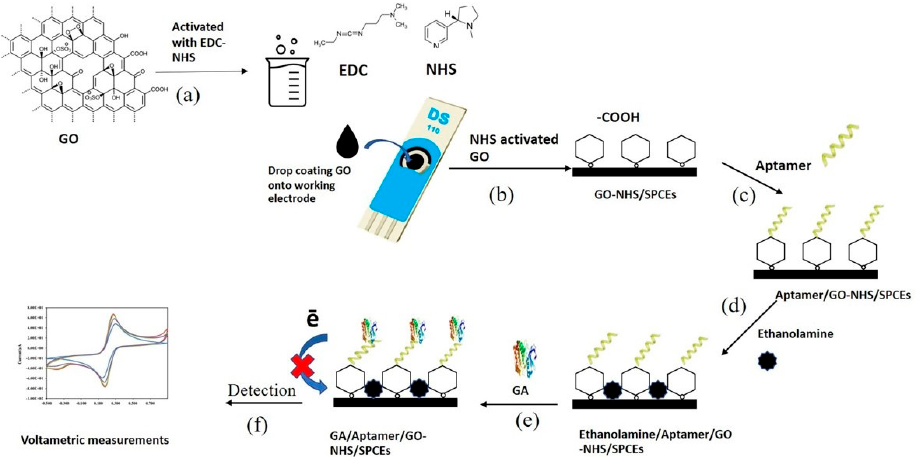
Figure 1. Schematic illustration of the proposed GO-based electrochemical aptasensor for GA protein detection. ( a ) Func- tionalization of GO; ( b ) drop-coating GO onto SPCEs; ( c ) immobilization of NH 2 aptamer; ( d ) blocking with ethanolamine; ( e ) incubation with GA protein; ( f ) voltametric measurements using 5 mM [Fe (CN) 6 ] 4–/3– as a redox indicator.